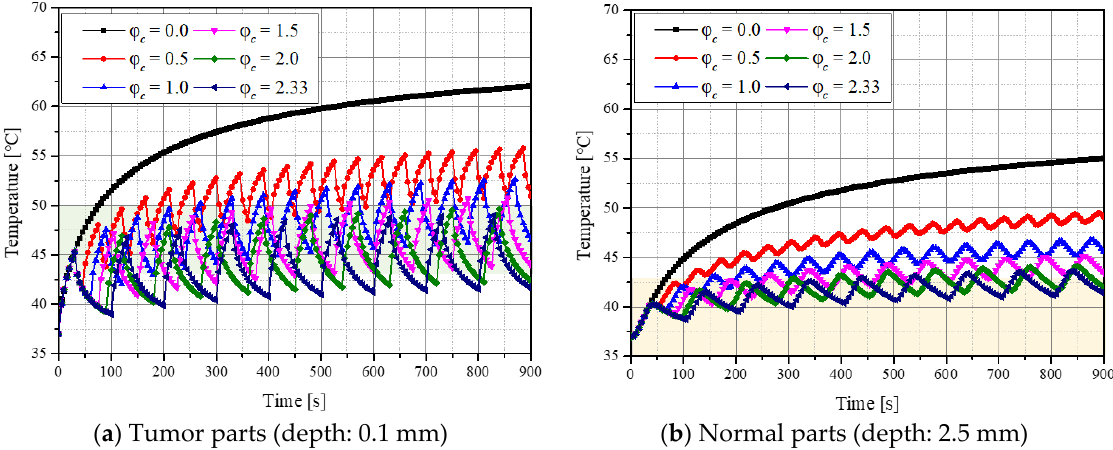
Figure 1. Temperature variation in the tumor and normal tissue over time for various cooling time ratios ( 𝜑 𝑐 ) ( f v = 10 -3 , P l = 200 mW)